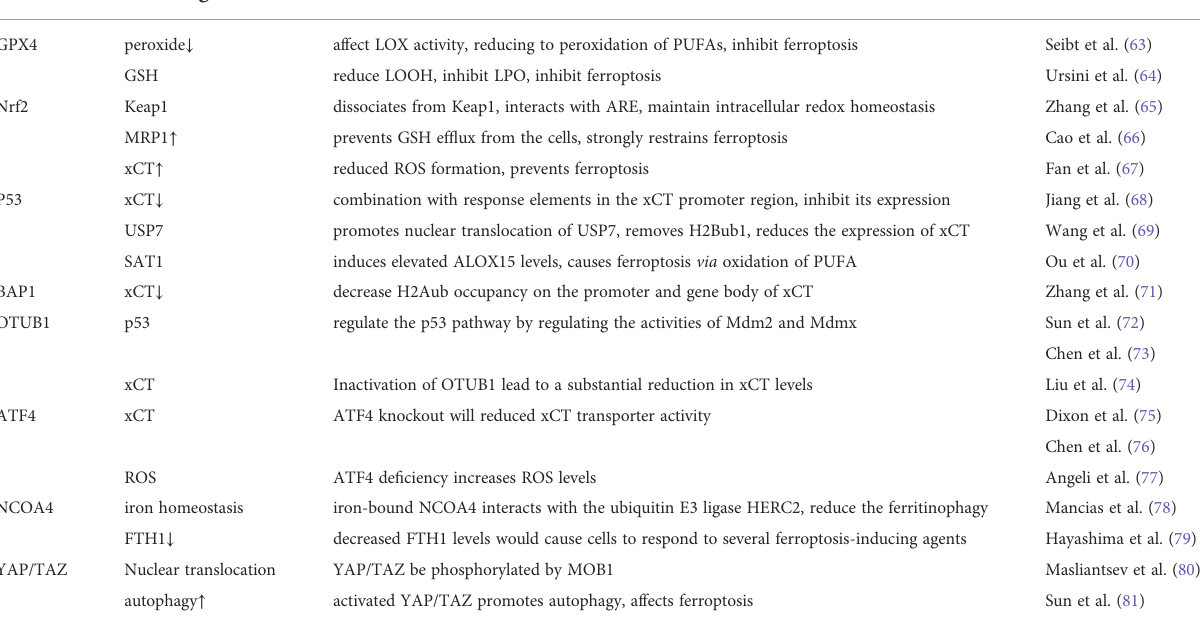
TABLE 1 Critical factors of ferroptosis in